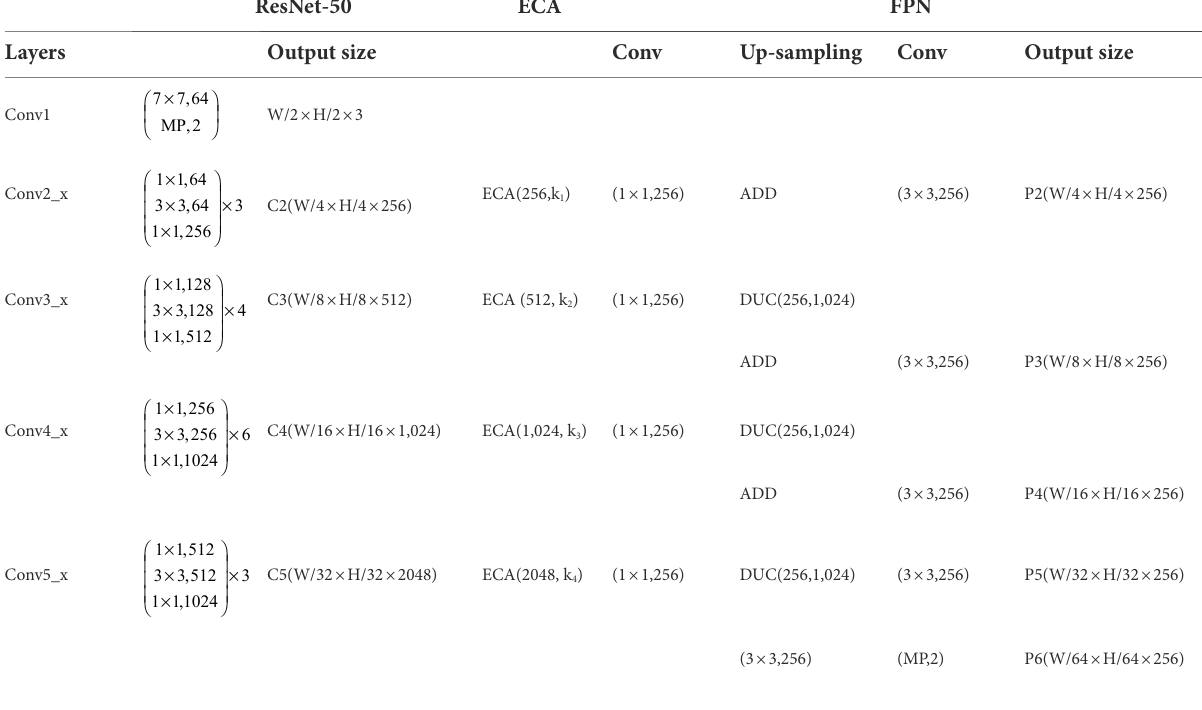
TABLE 1 Parameters of the improved Mask R-CNN backbone: ResNet50-FPN-ED network